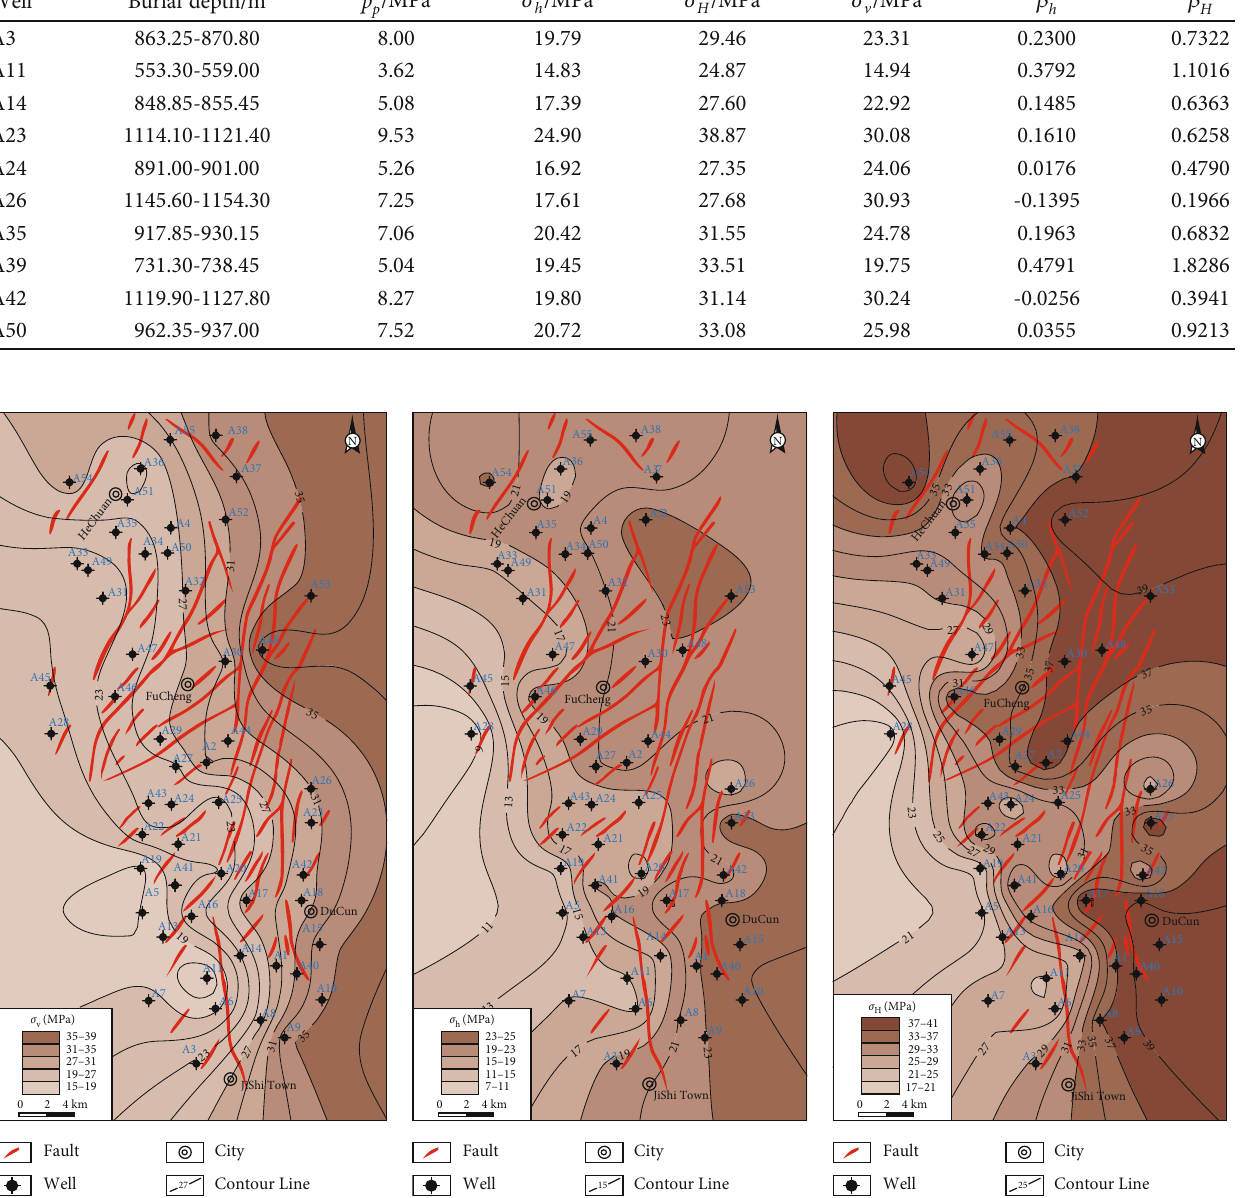
Table 2: Inversion for geostress parameters based on hydraulic fracturing data in the Anze Block. Well Burial depth/m